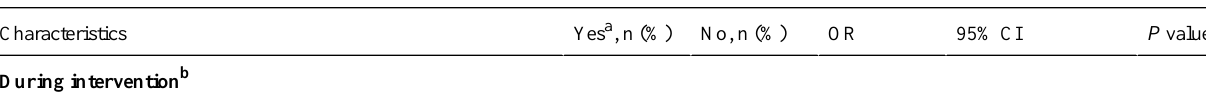
Table 2. Participants who reduced their time in the sun unprotected.